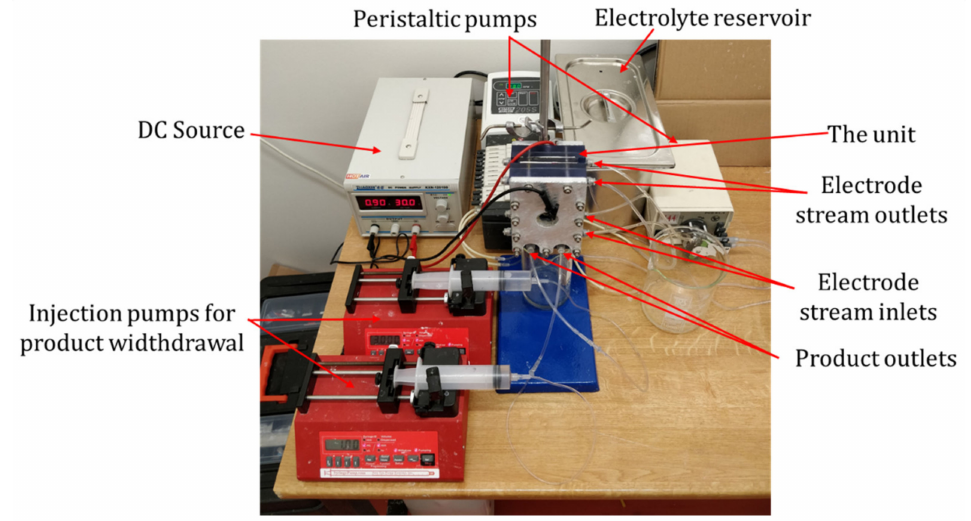
Figure 5. Testing setup. In this experiment, products were withdrawn using injection pumps, which is a method not employed to obtain the presented data. Otherwise, the setup is identical to the used one. The picture serves an illustrative purpose